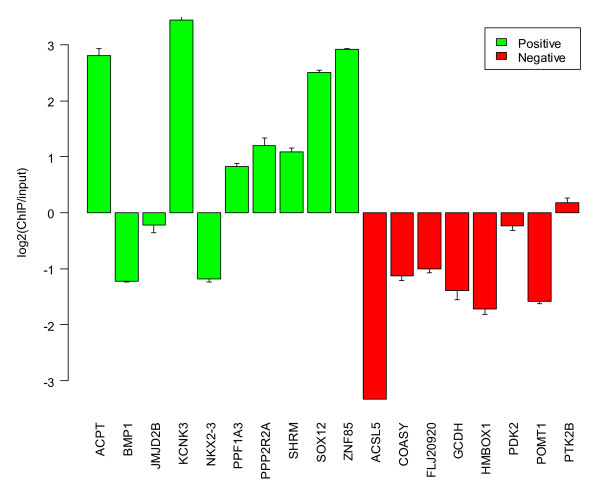
Seven out of ten promoters were confirmed to be active based on ChIP-PCR assays (green bars). Similarly, all but one of the promoters called as negative showed no evidence for RNA polymerase II binding (red bars). Error bars indicate standard errors from the mean, based on three replicates.